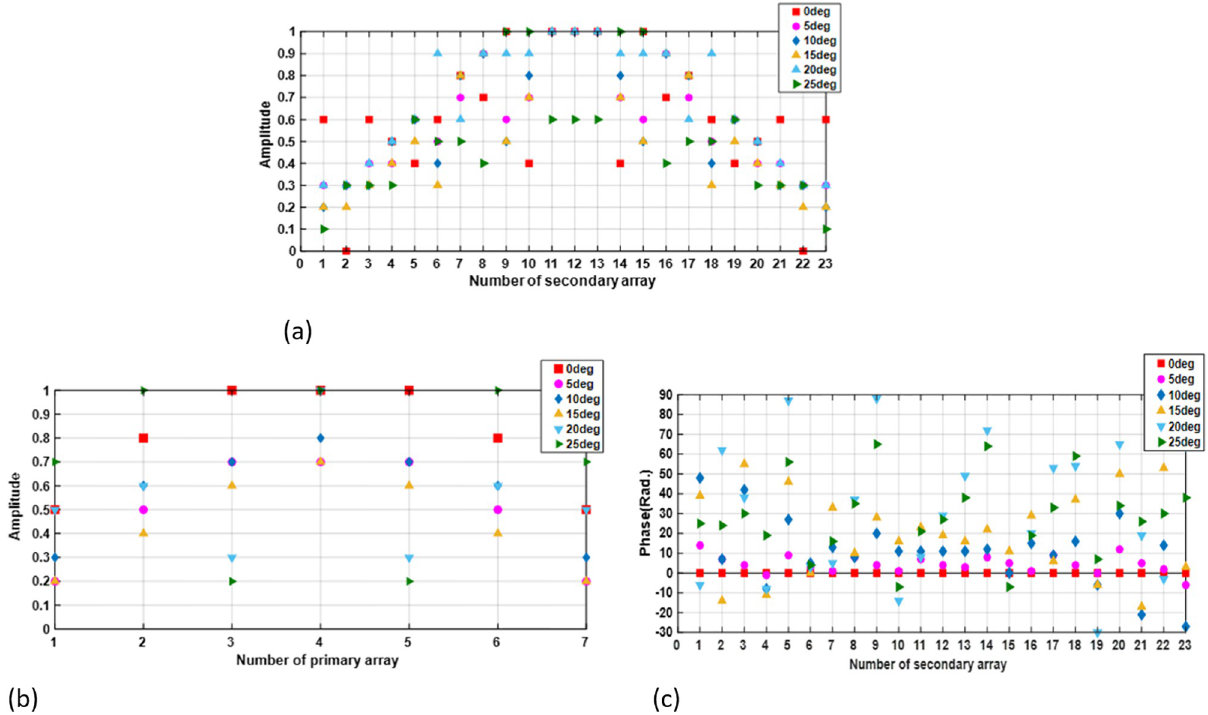
Fig 5. (a) Amplitude of 7 elements in the primary array (b) Amplitude of 23 elements in secondary array (c) phased of 23 elements in secondary array, for scan angle (0˚, 5˚, 10˚, 15˚, 20˚, 25˚). https://doi.org/10.1371/journal.pone.0277404.g005 The general structure of a beam-scanning linear array antenna is composed of the following units. A 1-to-10 power divider unit with cascaded unequal T-junction power dividers is used to divide the input power. Next, ten matched adjustable attenuators are used to provide ampli- tude tapering. The attenuator unit’s output is coupled to the ten adjustable phase-shifters unit, which sets the desired phase shifting to each element to steer the beam. The phase shifter unit’s outputs are fed into the 10-to-16 random overlap beamforming network (BFN). The BFN is a multiple input multiple output configuration consisting of mm-wave passive components such as a T-junction power divider, Wilkinson power combiner, cross-over, and transmission